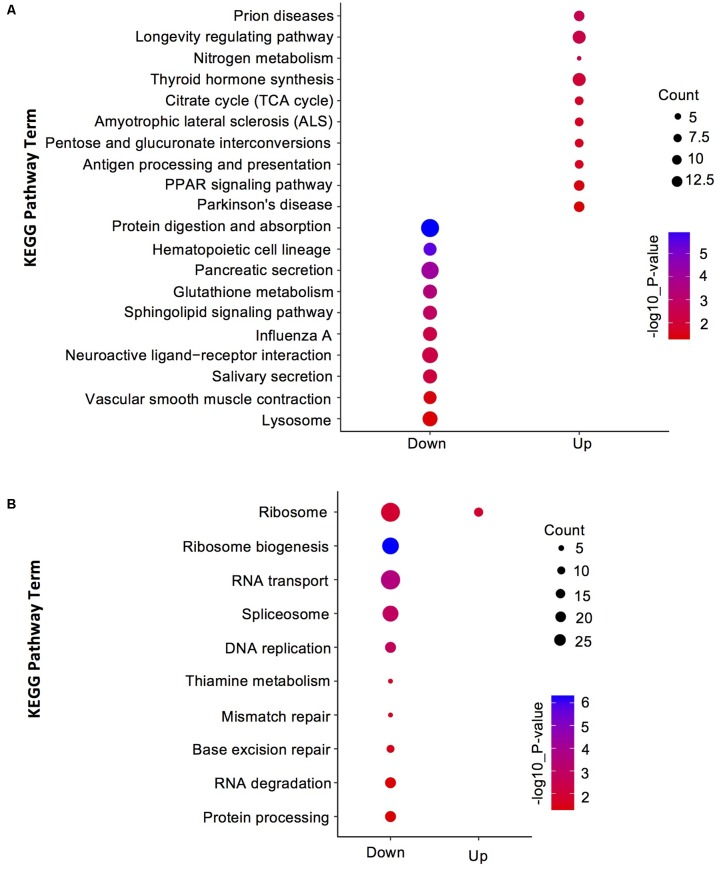
Kyoto Encyclopedia of Genes and Genomes (KEGG) pathway enrichment analysis for DEGs and DEPs in SF and PF. (A) Statistics of top 10 enriched pathways for DEGs in SF and PF. (B) Statistics of top 10 enriched pathways for DEPs in SF and PF. Up, up-regulated genes or proteins; Down, down-regulated gens or proteins.